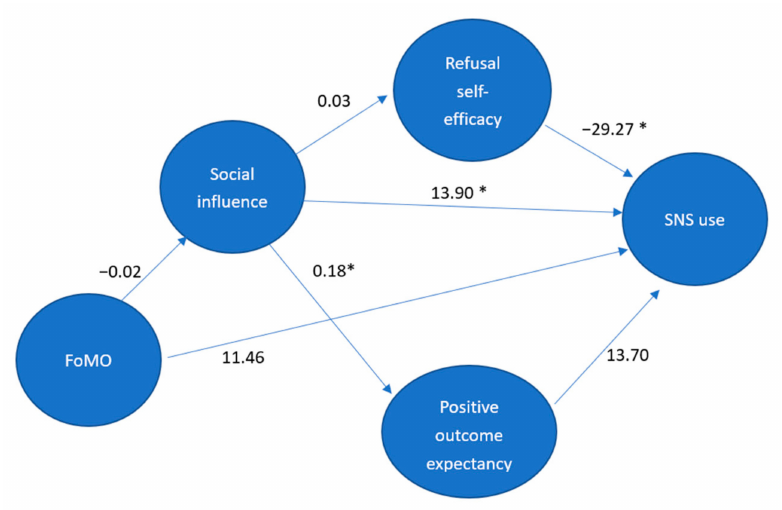
Figure 2. Estimates in hypothesized model. FoMO: fear of missing out; SNS use: Social networking sites use; *: p <